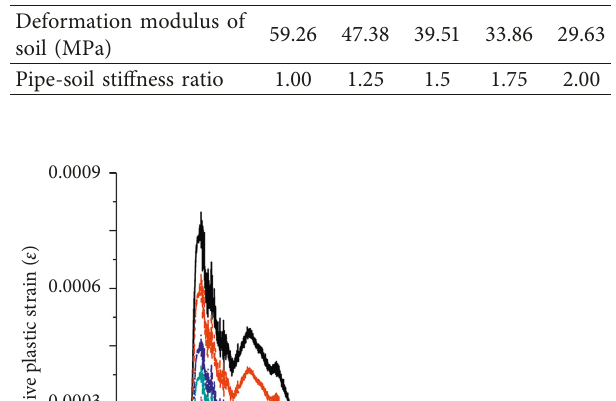
Table 9: Corresponding relation between soil deformation mod- ulus and pipe-soil stiffness ratio.